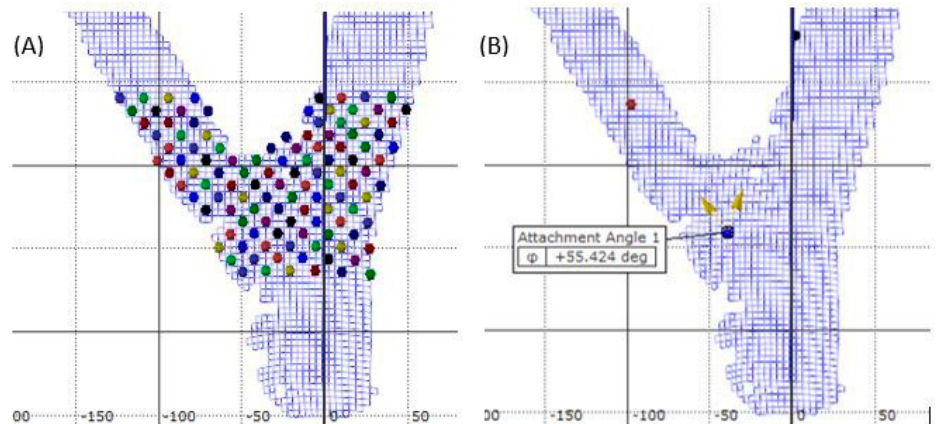
Figure 2. Example of the grid system ( A ) of test points used for post-processing measurement of and ( B ) example of the measurement of separation angle using DIC software on codominant red maple.